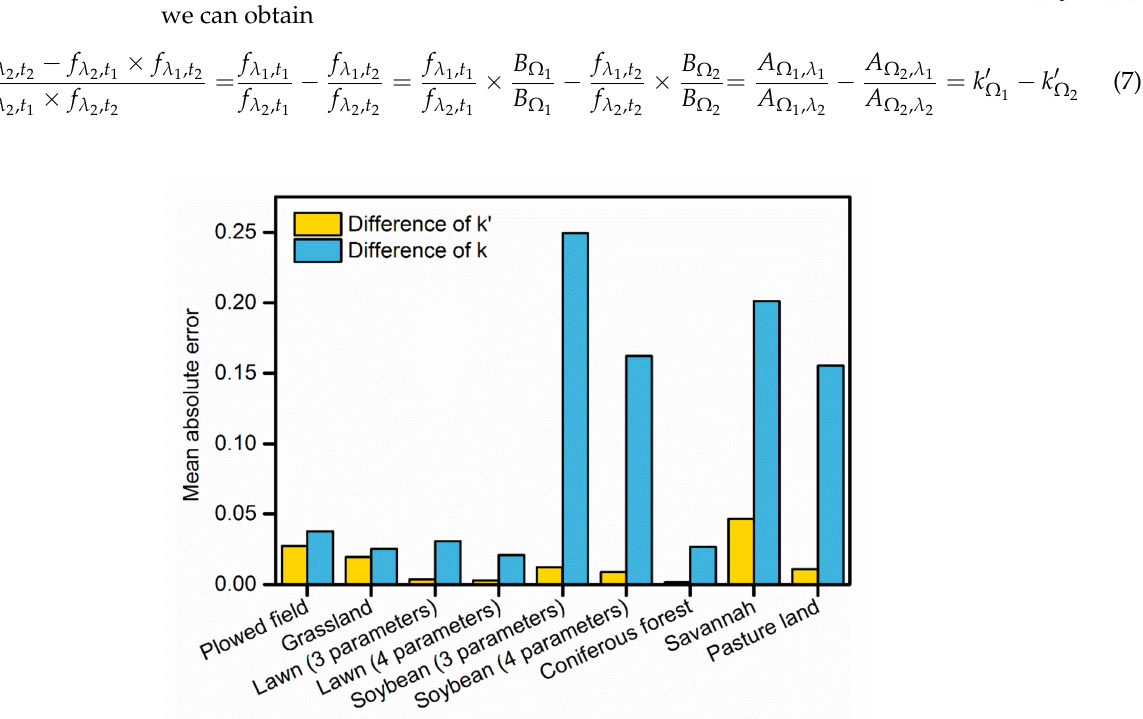
− k (cid:48) Ω − k and k λ λ 2 for different ground cover 1 2 1